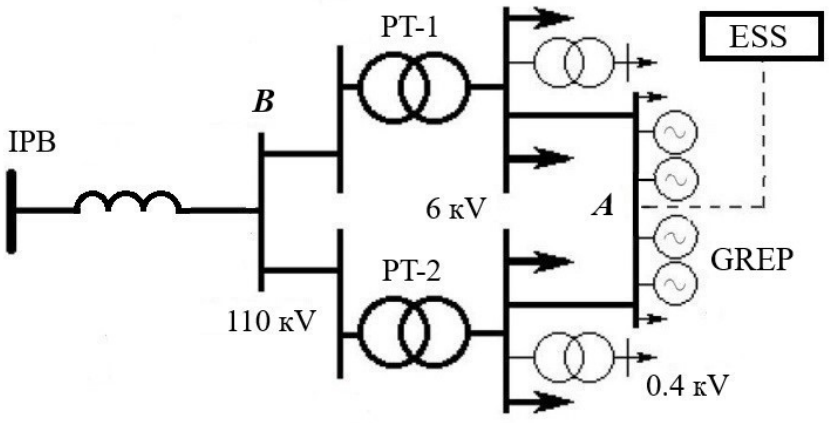
Figure 1. Simplified single-line diagram of the power supply system of an industrial facility with several GREPs.